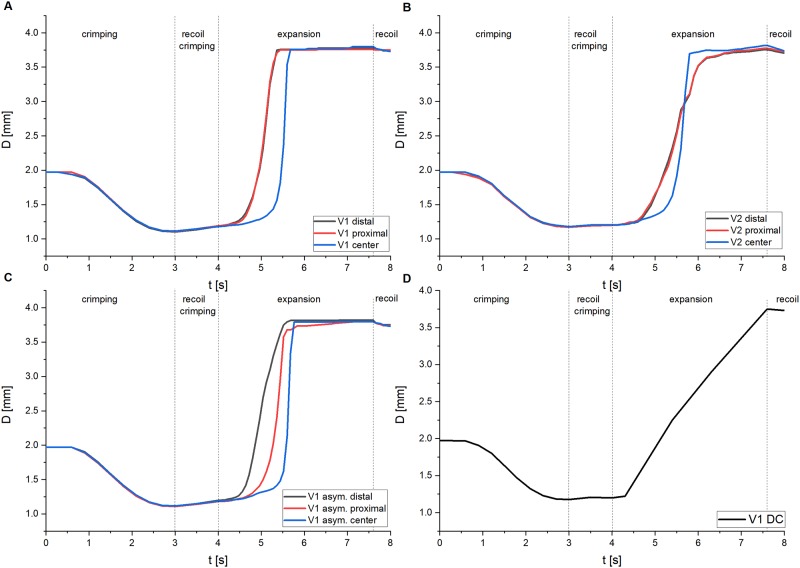
Numerically determined diameter course within the simulation of the entire stent life-cycle.A: Detailed stent life-cycle simulation of stent V1. B: Detailed stent life-cycle simulation of stent V2. C: Detailed stent life-cycle simulation of an asymmetrical positioned stent V1. D: Displacement-controlled expansion of stent V1. Within the evaluation of the results from the detailed simulation approach (A, B, C), a distinction was also made between the diameter progression of the stent ends (red) and the central part of the stent.